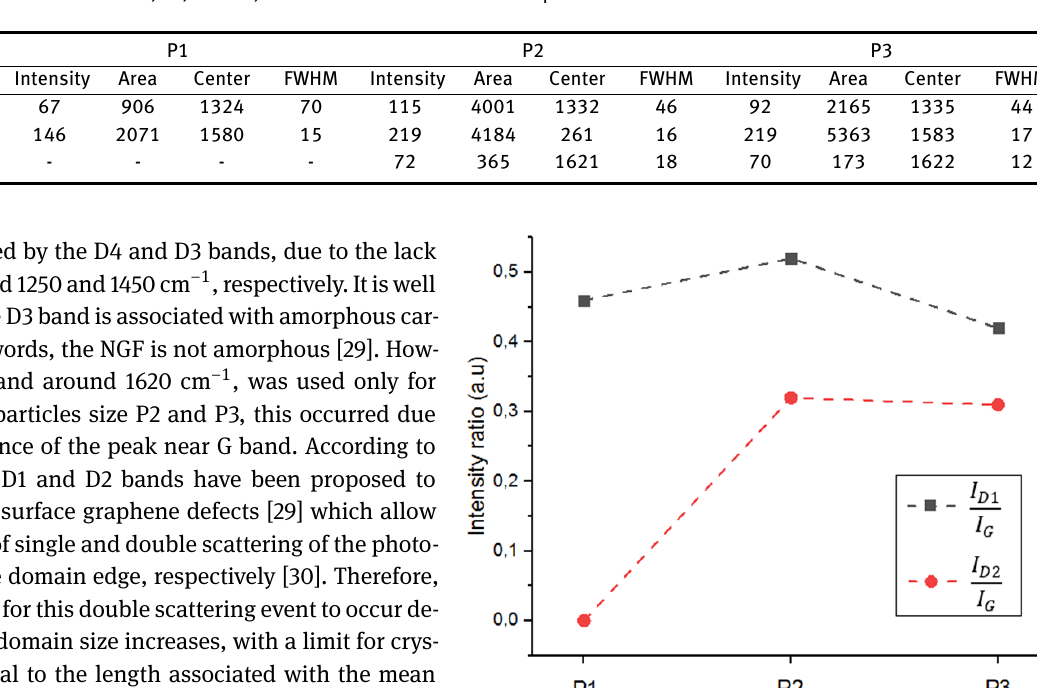
Figure 5: Intensity ratios involving D1, D2 and G bands as function of particle size of